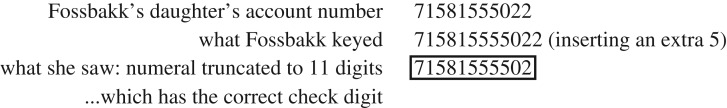
Fossbakk used her bank’s user interface to transfer money to her daughter’s account. Unfortunately she double-pressed a key, resulting in a longer account number. The user interface truncated the number, thus obtaining another, but valid, account number. Thinking she had keyed the correct number, Fossbakk confirmed the transfer, despite it being to a differently-named account, which apparently was not displayed, checked or confirmed. Details taken from Olsen [13].